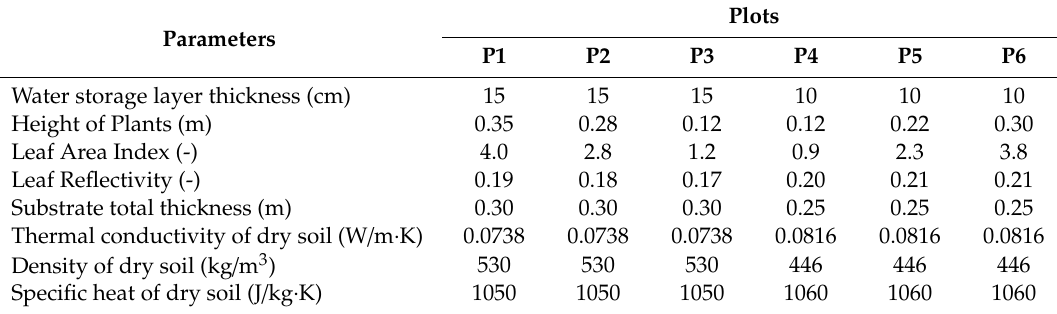
Table 2. Description of the layers constituting the green roof plot.